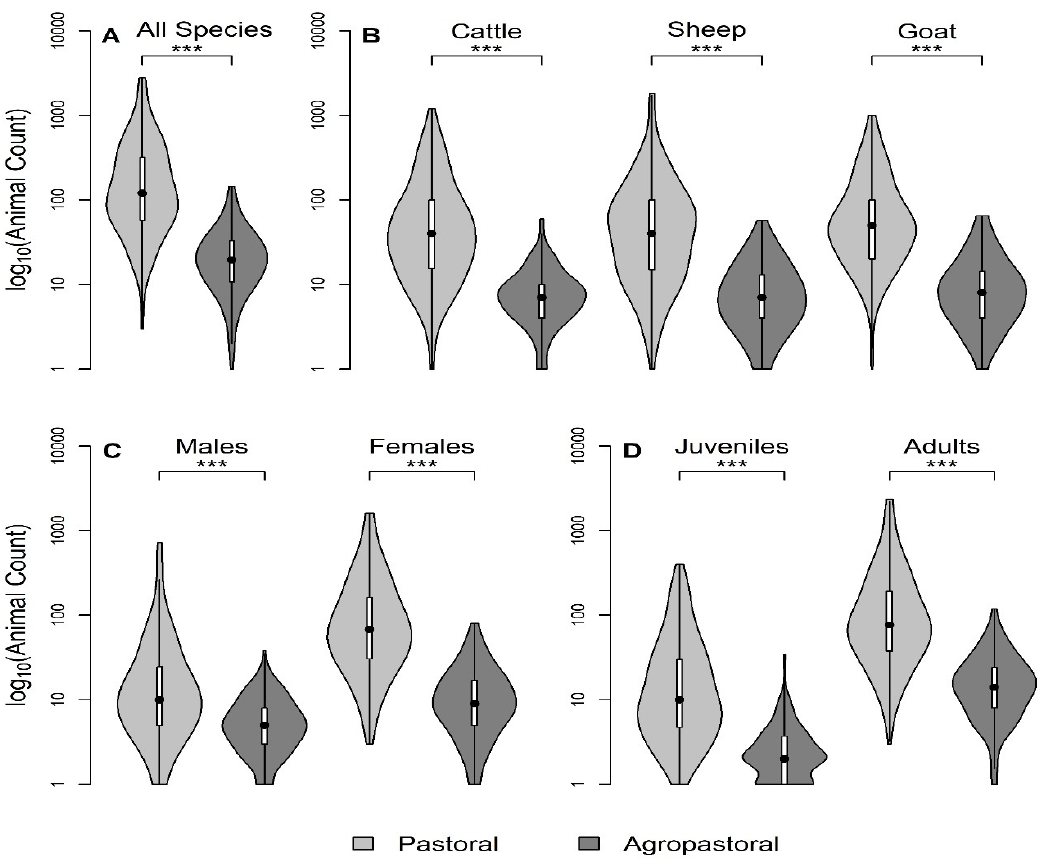
Figure 2. Herd size is greater in pastoral systems than agropastoral systems among livestock keeping households in northern Tanzania. Violin plots of the distribution of self-reported compound-level herd size (log 10 ) by production system for the following stratifications: ( A ) all species, ( B ) by species, ( C ) all species adults by sex, and ( D ) all species by binary age groups (juvenile = no adult teeth). Herd size and stratification variables are all from household questionnaires. *** All comparisons significant ( p < 0.001) by Kruskal–Wallis test. Boxplots are embedded within the violin (shows probability density of data at different values). All violin plots have equal maximum width.